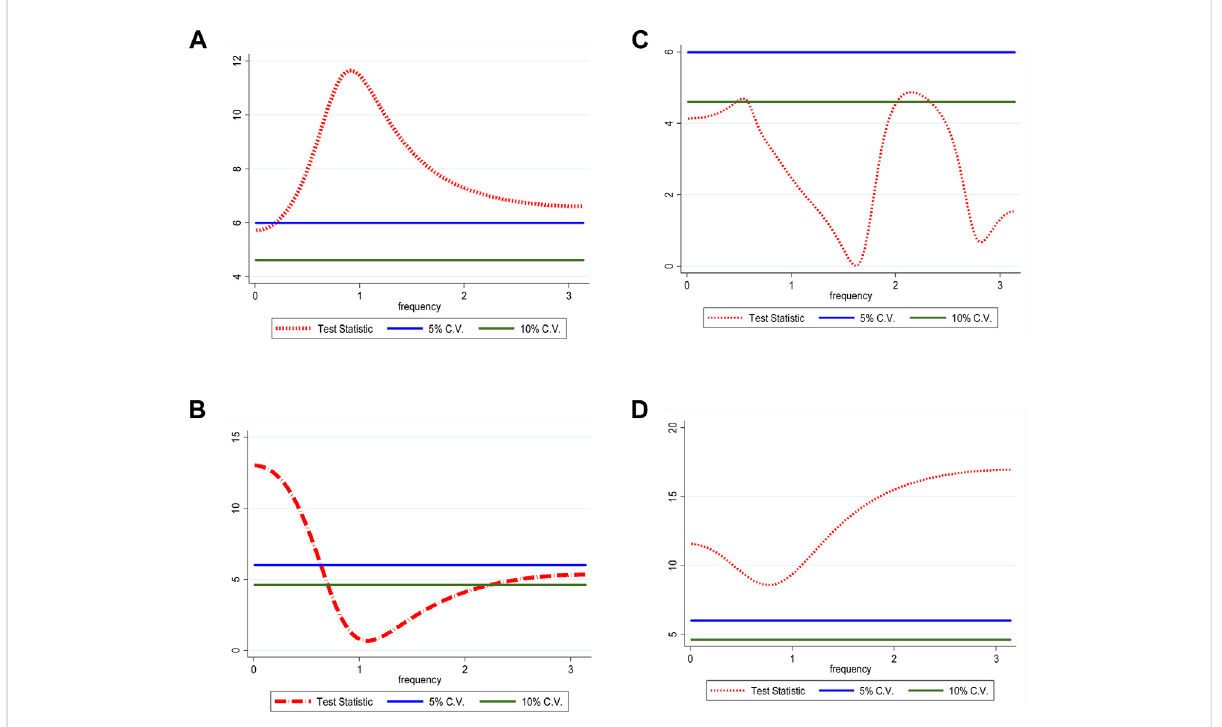
FIGURE 5 (A) Causality from REC to LF. (B) Causality from GDP to LF. (C) Causality from TEC to LF. (D) Causality from NREC to